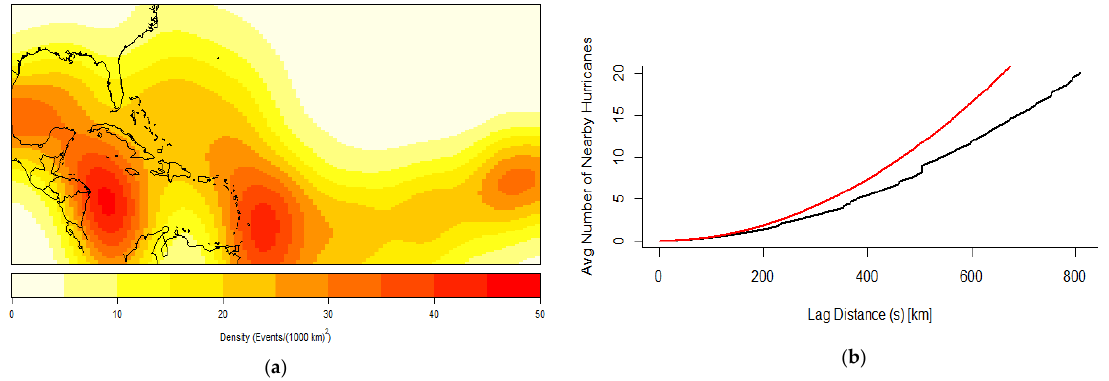
Figure 11. ( a ) Kernel density analysis of RI hurricanes at their origin points (1851 – 2017). ( b ) Generalization of K graph for inhomogeneous data with the empirical (black) curve above the theoretical (red) curve for lag distances less than 150 km, indicating the likelihood of clustering up to this distance.